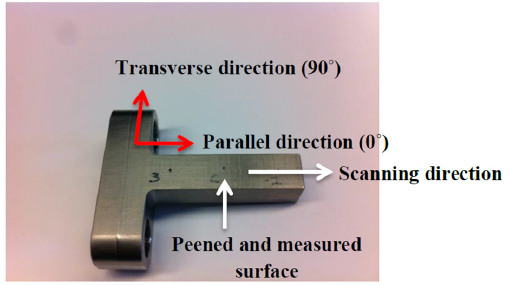
Figure 3. Illustration of 0° and 90° directions relative to the laser scanning direction on a peened